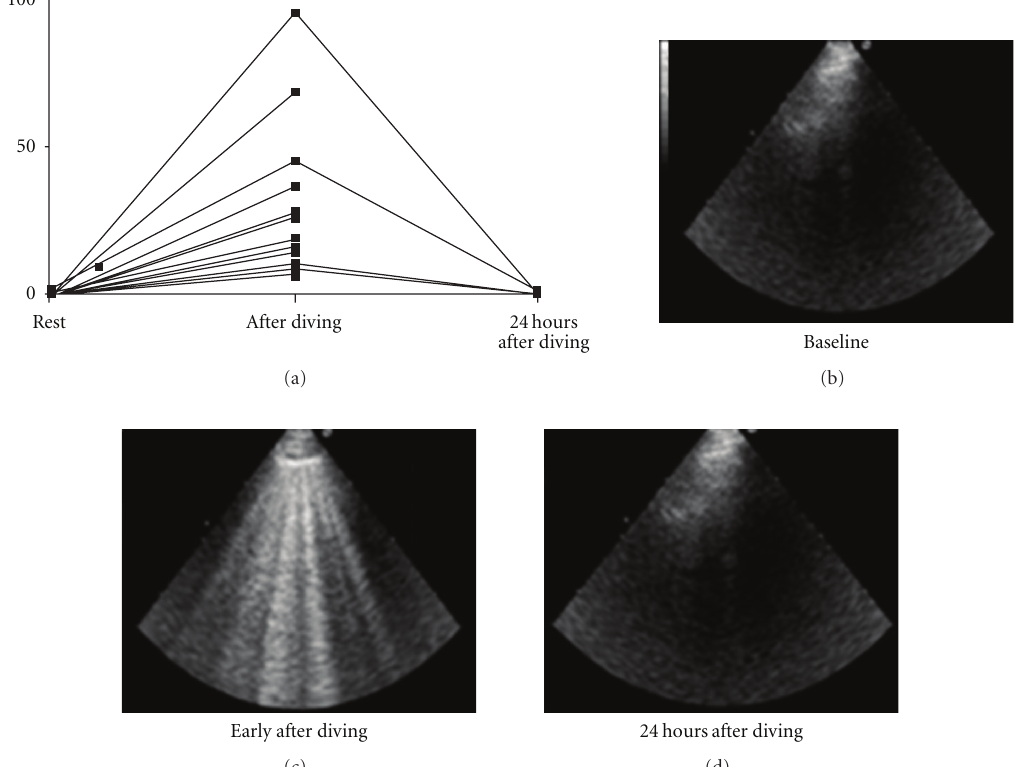
Figure 3: Chest ultrasonography revealed an increased number of ULCs within 10 minutes after immersion in 45% of 14 top-level breath- hold deep divers, which resolved completely after 24 hours (Frassi et al.